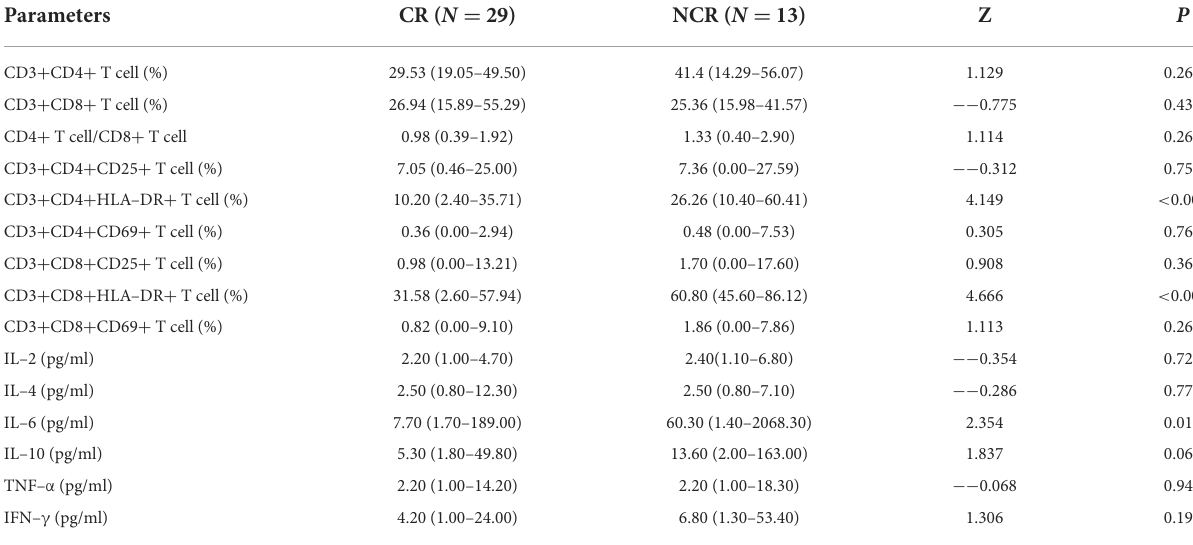
TABLE 2 Comparisons of indicators between CR and non-CR group.